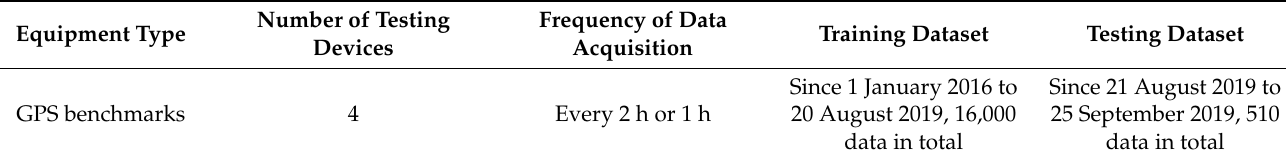
Table 4. Training and testing dataset.